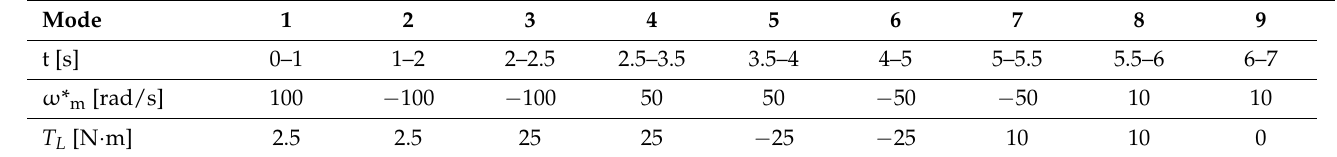
Table 2. Different operation modes of the proposed IM drive